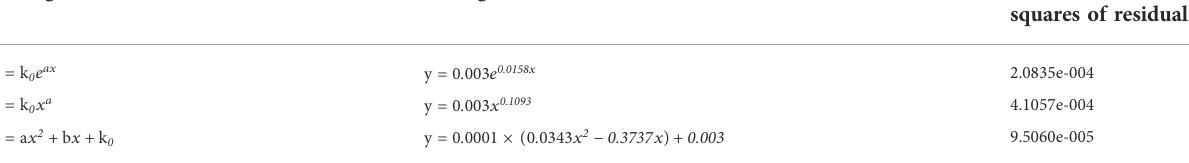
TABLE 2 Comparison of fi tting results of different methods.